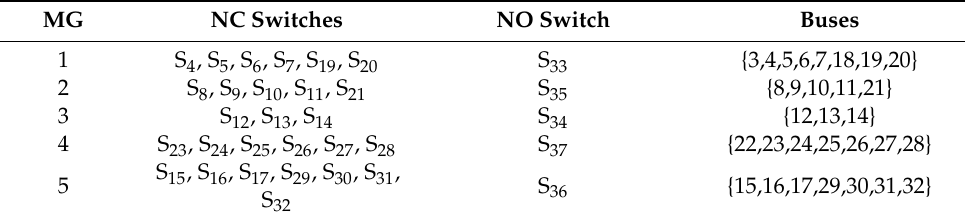
Table 1. The initial state of the distribution test system.